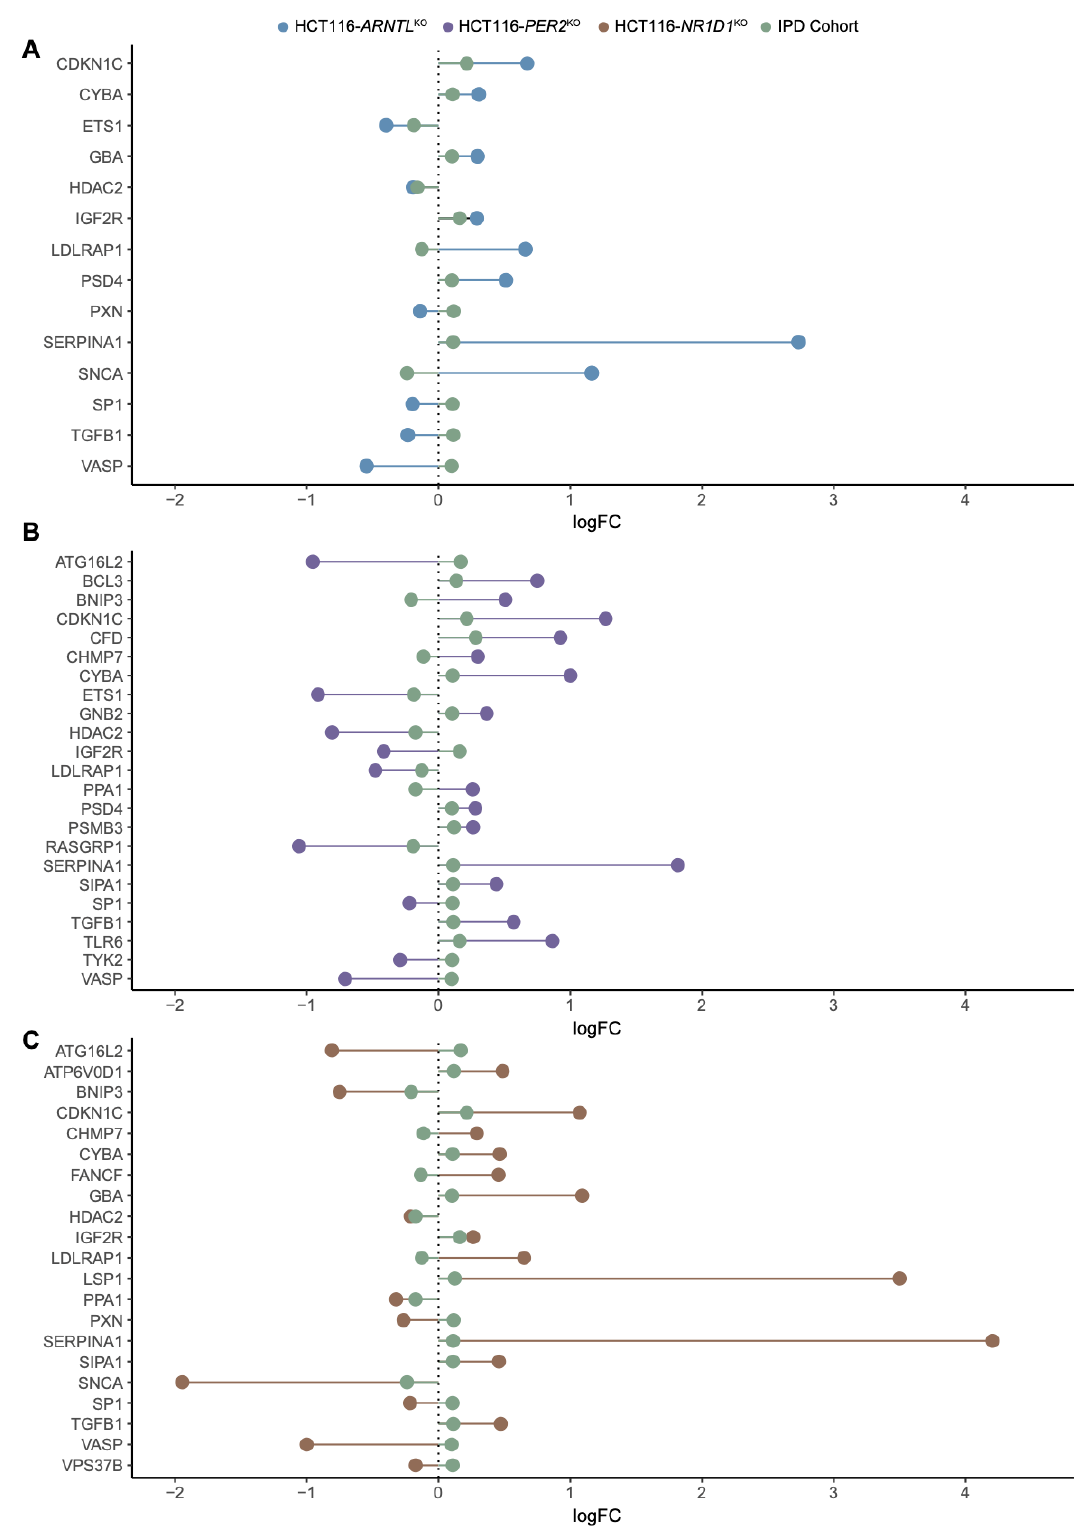
Figure 4. Common differentially expressed genes of interest in HCT116 KO cells and IPD cohort. Lollipop plots show the direction of changes (up/downregulation) in mean gene expression levels (log 2 FC in comparison to respective controls) for the genes of interest shared between ( A ) HCT116- ARNTL KO versus HCT116 WT and IPD patients versus controls ( B ) HCT116- PER2 KO versus HCT116 WT and IPD patients versus controls ( C ) HCT116- NR1D1 KO versus HCT116 WT and IPD patients versus controls.